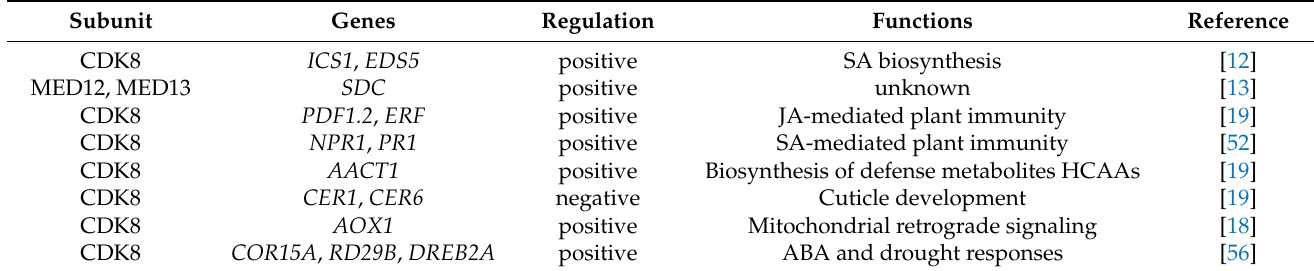
Table 1. Genes regulated by the CDK8 module in Arabidopsis